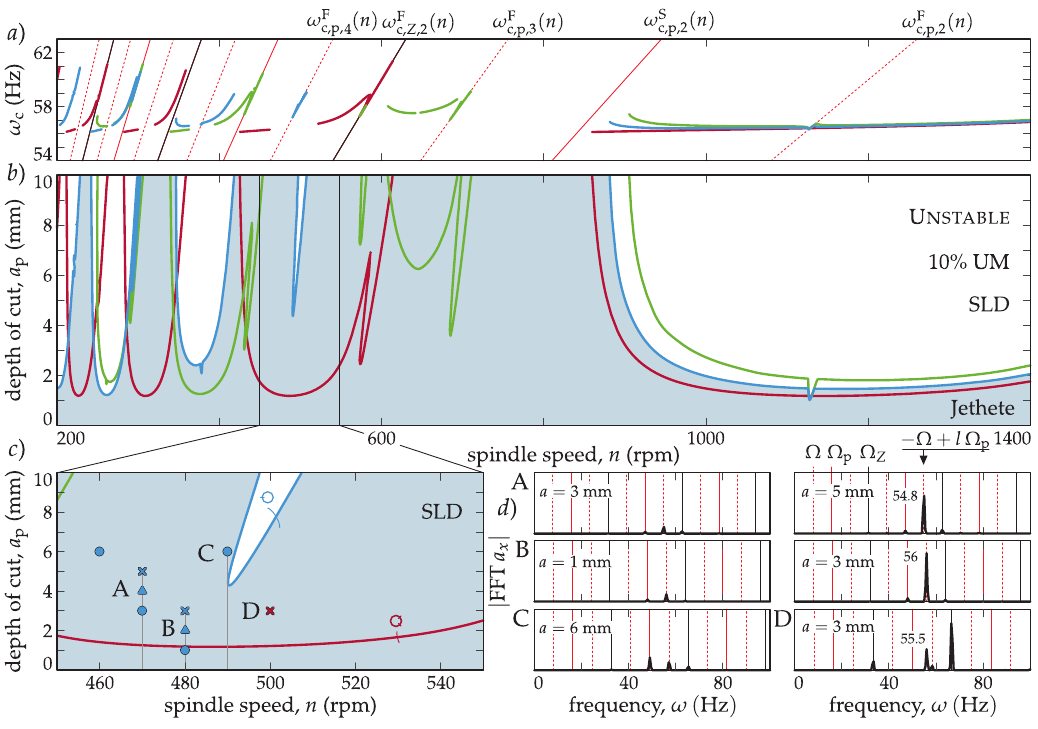
(green: BF, red: regular, blue: BS.), while ( c ) is the magnified area where the tests were performed (circle: stable, cross: unstable tests, triangle: marginal). The essential spectra are presented in panel ( d ); a new kind of flip (A, B, C) and Hopf (D) stability losses can be